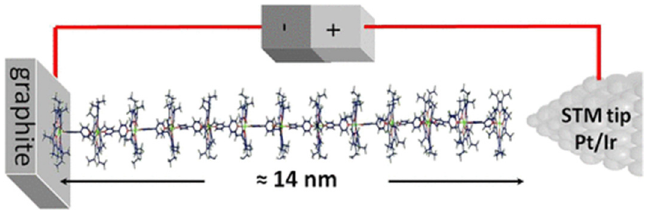
Figure 2. Self-assembled molecular porphyrin wire up to 14 nm in length. Republished with permission from The Journal of Physical Chemistry, from [30] Copyright 2022.